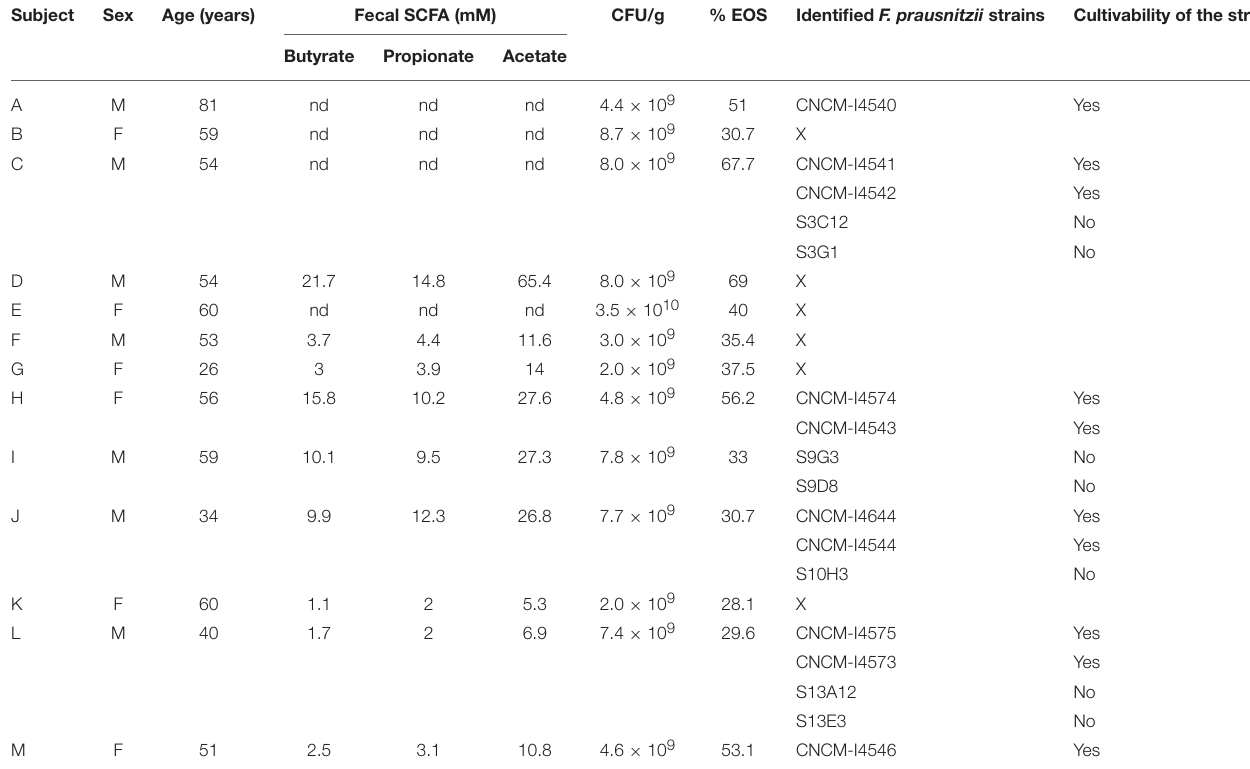
TABLE 1 | Studied cohort of healthy humans’ volunteers and new F. prausnitzii strain